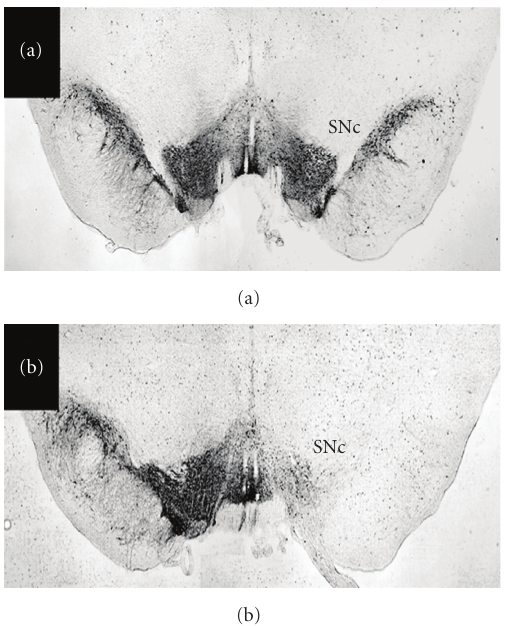
Figure 2: Photomicrographs of tyrosine hydroxylase immuno- stained nigra of a control (a) and 6-OHDA lesioned (b) rat. Images are representative of the e ff ect of a saline/sham microinjection (a) and 6-OHDA lesion (b) of the MFB on the SNc. The nigral DA neurons are highly TH-immunoreactive; note the lack of staining on the right side of (b), indicative of a large lesion of the dopaminergic SNc. In contrast, there is preservation of the nigra on the targeted (right) side in (a). MFB, medial forebrain bundle; SNc, substantia nigra pars